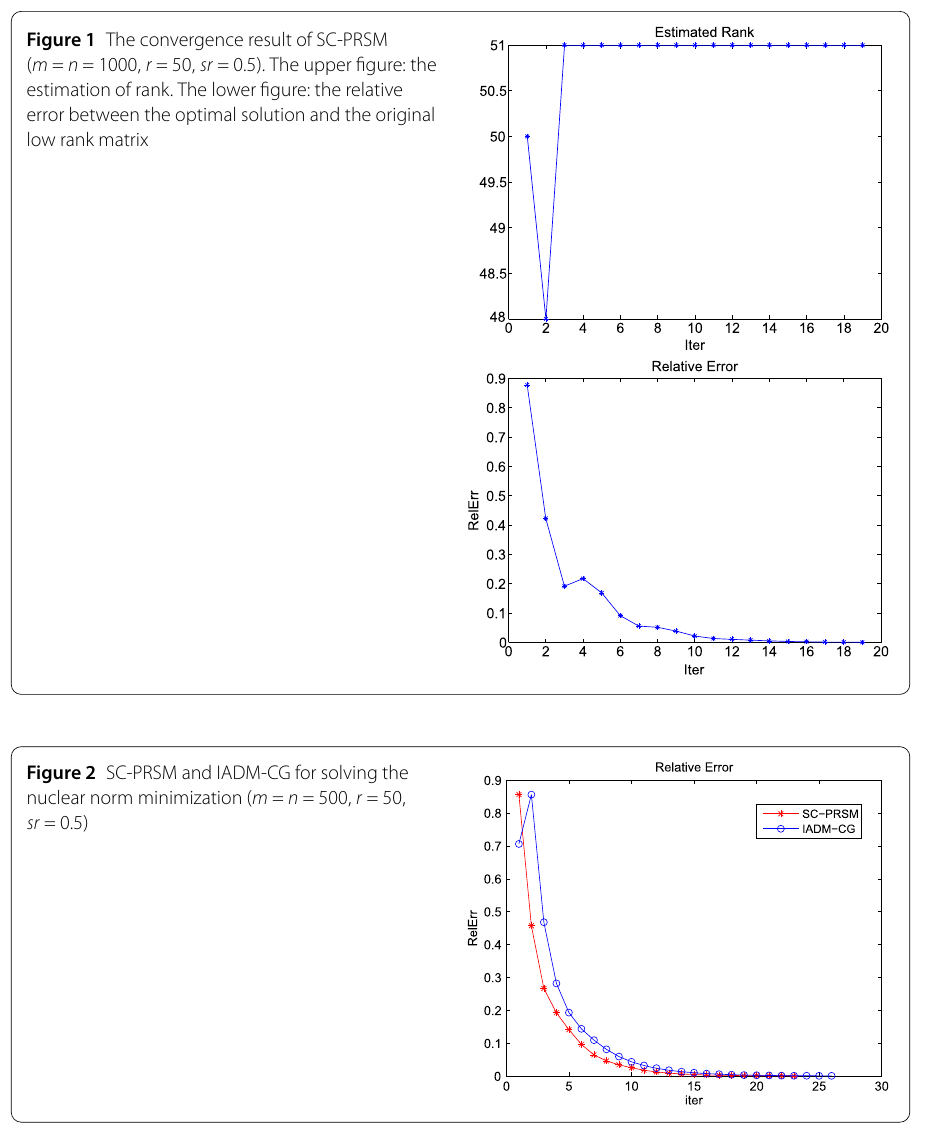
Figure 1 The convergence result of SC-PRSM ( m = n = 1000, r = 50, sr = 0.5). The upper figure: the estimation of rank. The lower figure: the relative error between the optimal solution and the original low rank matrix